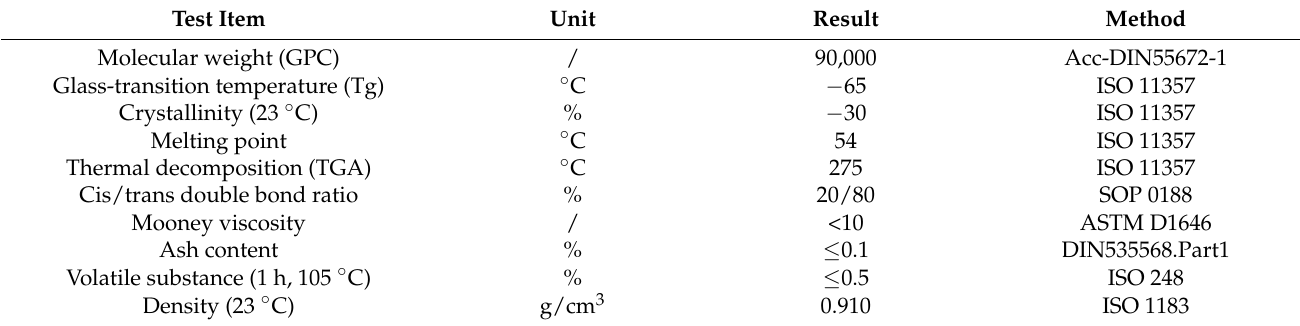
Figure 7. The infrared spectrum diagram of TOR.